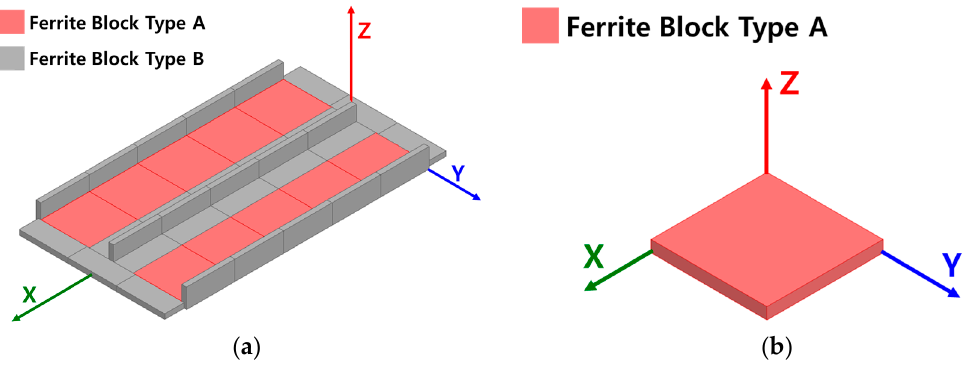
Figure 16. Ferrite core assemblies for the ( a ) source coil and ( b ) load coil unit.